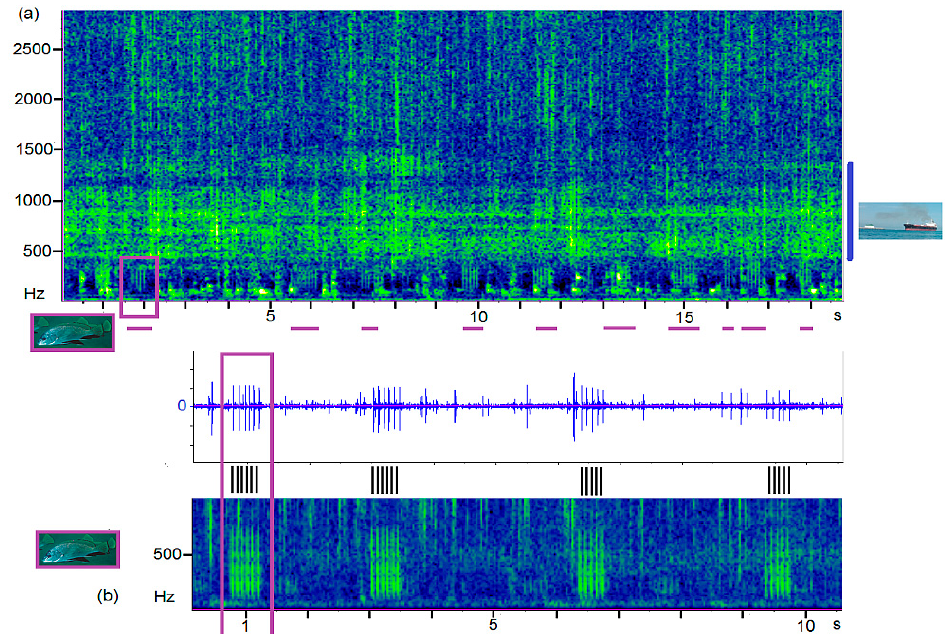
Figure 2. ( a ) Spectrogram (FS = 44.1 kHz, resampled at 6 kH, FFT = 512, and 50% overlap) of an acoustic sample containing both the noise of a distant cargo passing through the Venice inlet (most of the energy was located in the frequency range of 400–1100 Hz; blue line) and the sounds of the target species, Sciaena umbra , visible below 400 Hz (indicated by the purple square and lines). ( b ) Spectrogram (FS = 44.1 kHz, resampled at 6 kH, FFT = 512, and 50% overlap) and waveform of four Sciaena umbra sounds made by a series of low frequency pulses; the black bars indicate the number of pulses per sound, as scored in accordance with [11,26].